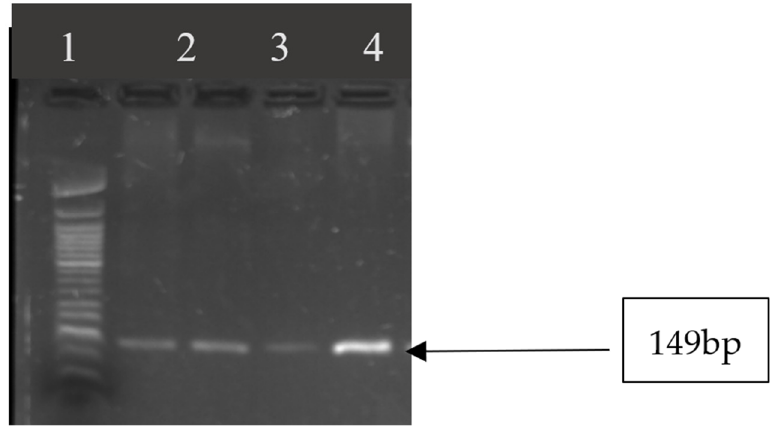
Figure 4. Image showing seg gene amplicons observed on agarose gel. Lane 1: 50 bp DNA ladder; lanes 2–5 show amplicon sizes for samples that were positive for seg gene (149 bp).